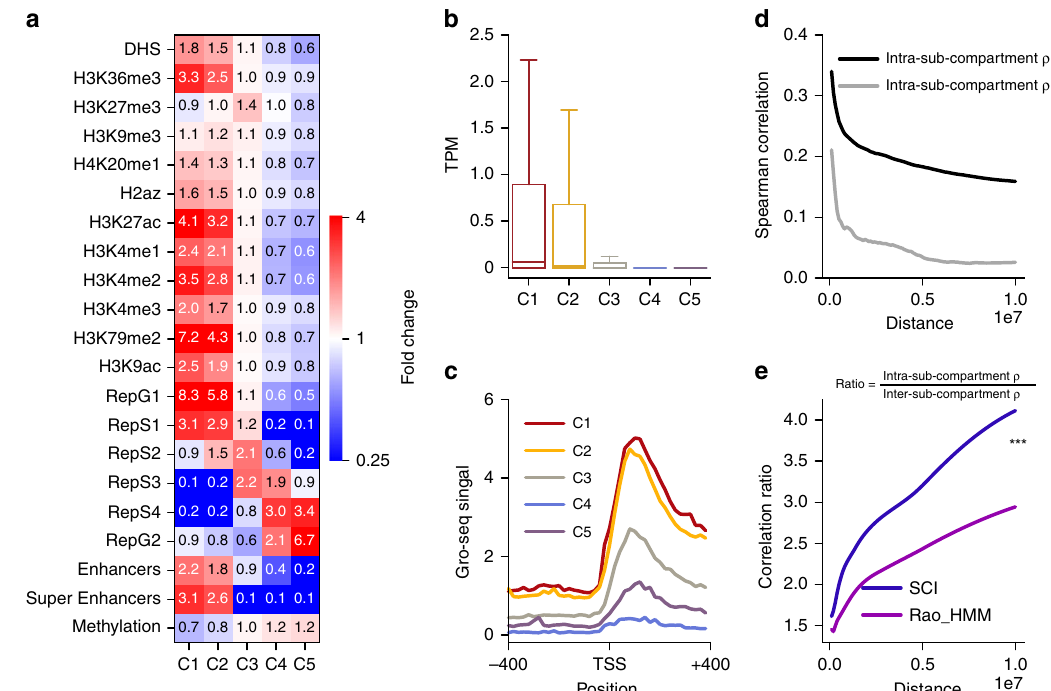
Fig. 3 SCI sub-compartments have distinct genomic features. a Heatmap of distinct epigenomic sub-compartments predicted by SCI. b Boxplot of gene expression in transcripts per million (TPM) for different compartments. C1 and C2 have higher gene expression compared to other sub-compartments. c Cumulative GRO-seq signal over the promoter regions for all the genes in each sub-compartment. d Pairwise gene-expression Spearman ’ s correlations vs. distance between gene pairs within the same sub-compartment (in black) vs. gene pairs across sub-compartments (gray) within 10 Mbps. e Spearman ’ s correlation coef fi cient ratio ( y -axis) of gene pairs within the same sub-compartment (in black) vs. gene pairs across sub-compartments plotted against genome distance ( x -axis) for SCI (blue) and HMM prediction. Asterisks (***) represent p -value < 2.2e − 16 using paired Wilcoxon test.